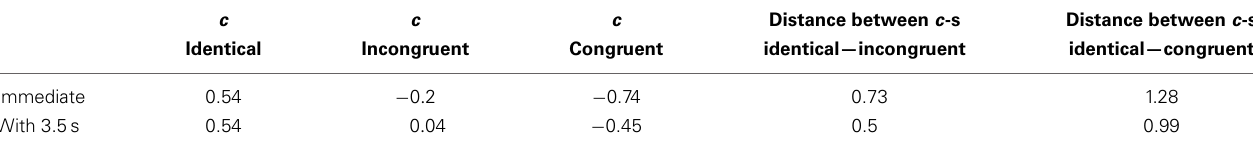
Table 4B | As in the Table 4A, but for the distances and values of c .